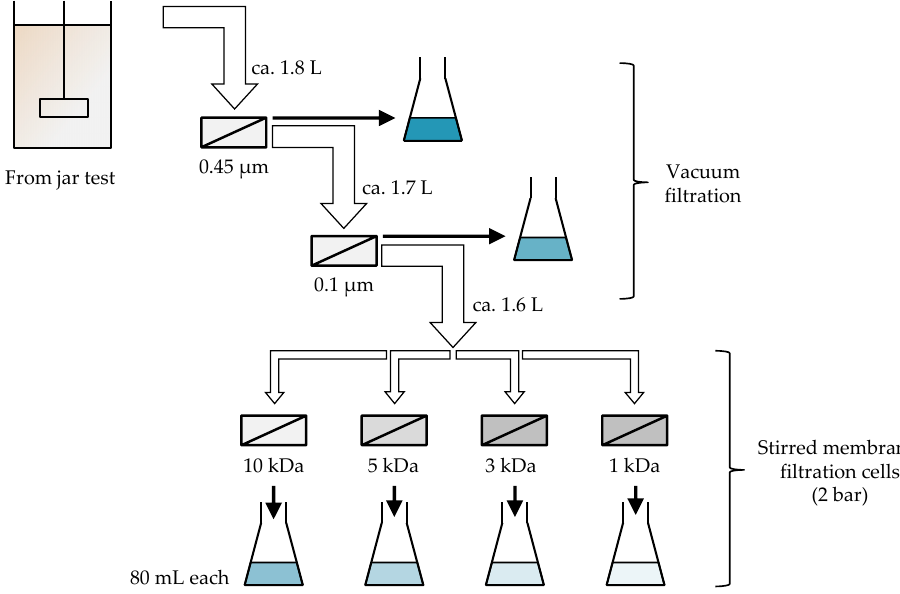
Figure 1. Scheme of the fractionation procedure.